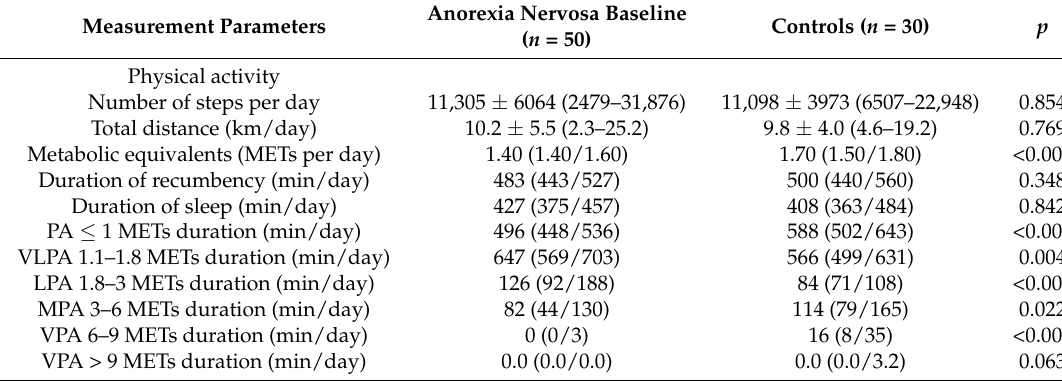
Table 2. Physical activity and the division into different MET cut-offs in patients with anorexia nervosa on admission and in the healthy control